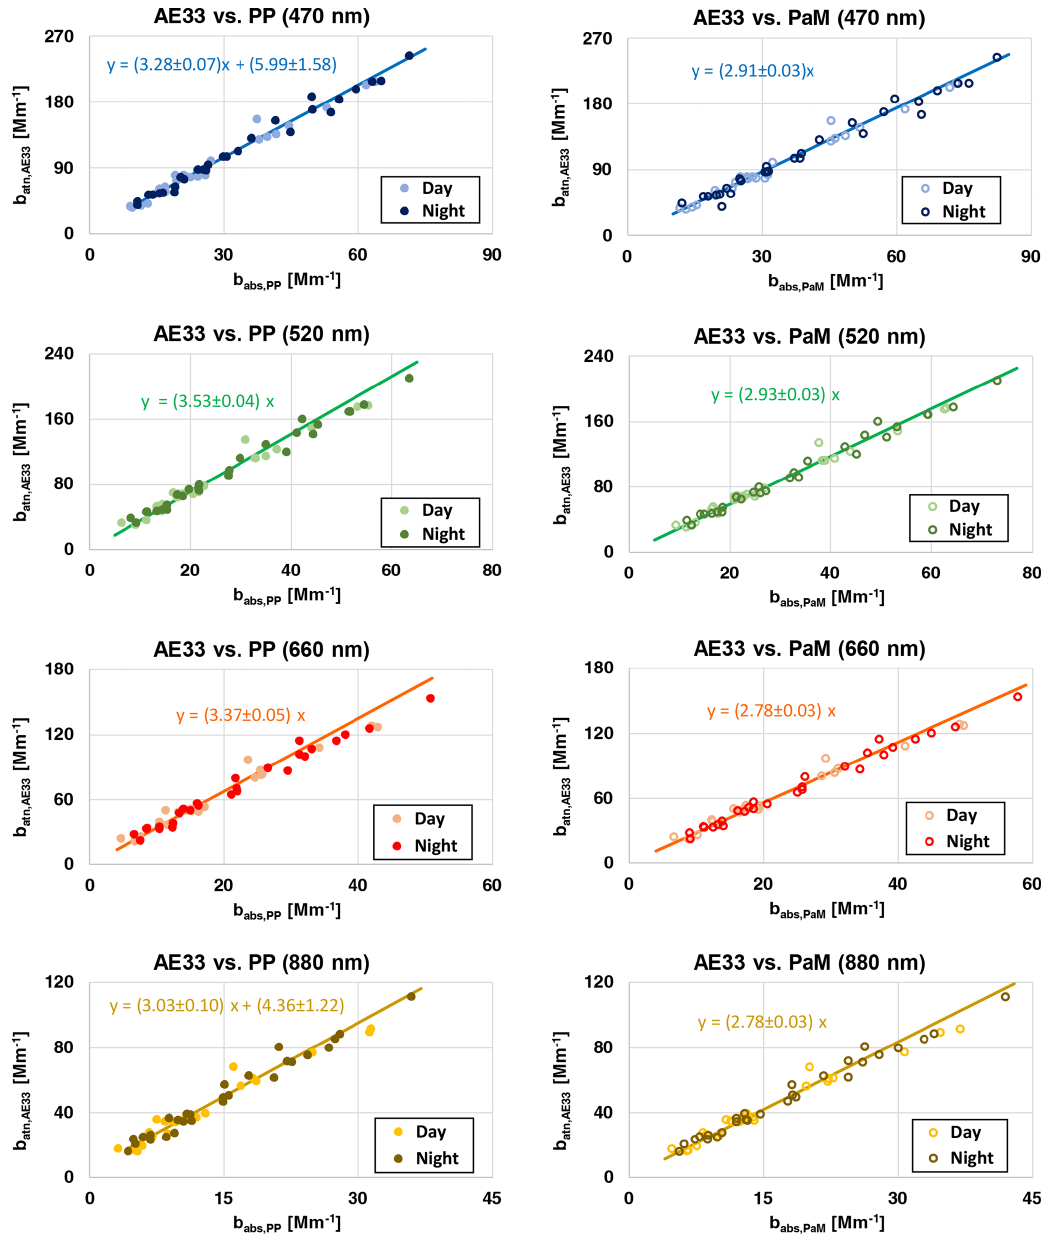
Figure 2. Scatterplot of b ATN_AE33 (λ) vs. b abs_PP (λ) (left charts) and b abs_PaM (λ) (right charts) at 470, 520, 660, and 880nm (from top to